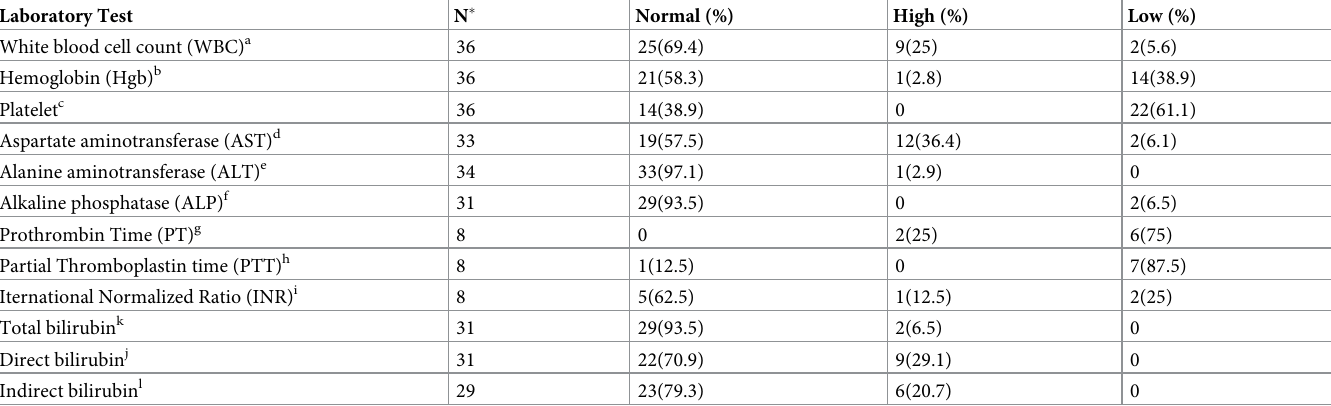
Table 2. Laboratory characteristics of patients treated as LBRF at Jimma Medical Center, Ethiopia, May–July